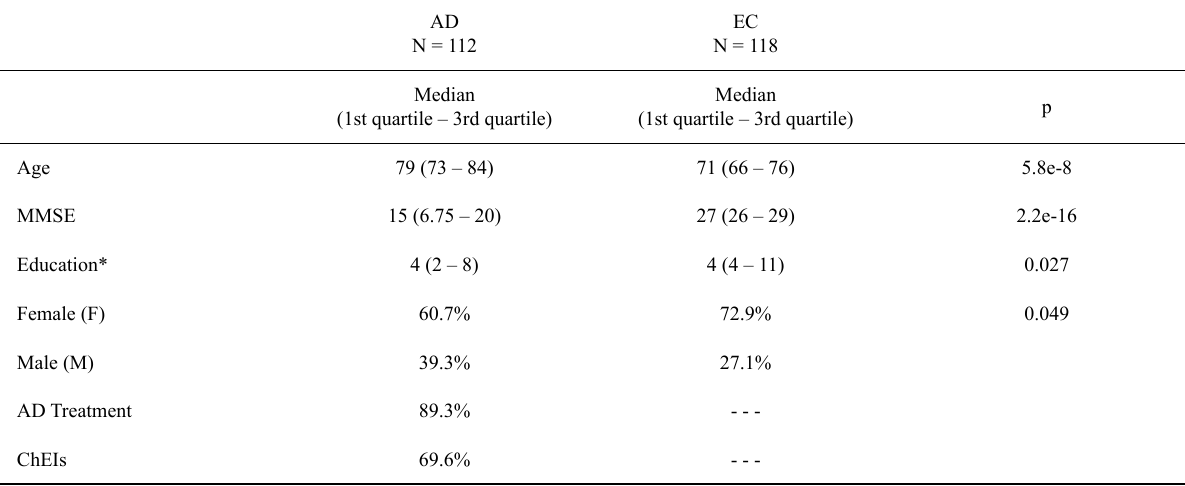
Table 1 – Demographics and characteristics of Alzheimer patients (AD) and elderly controls (EC).